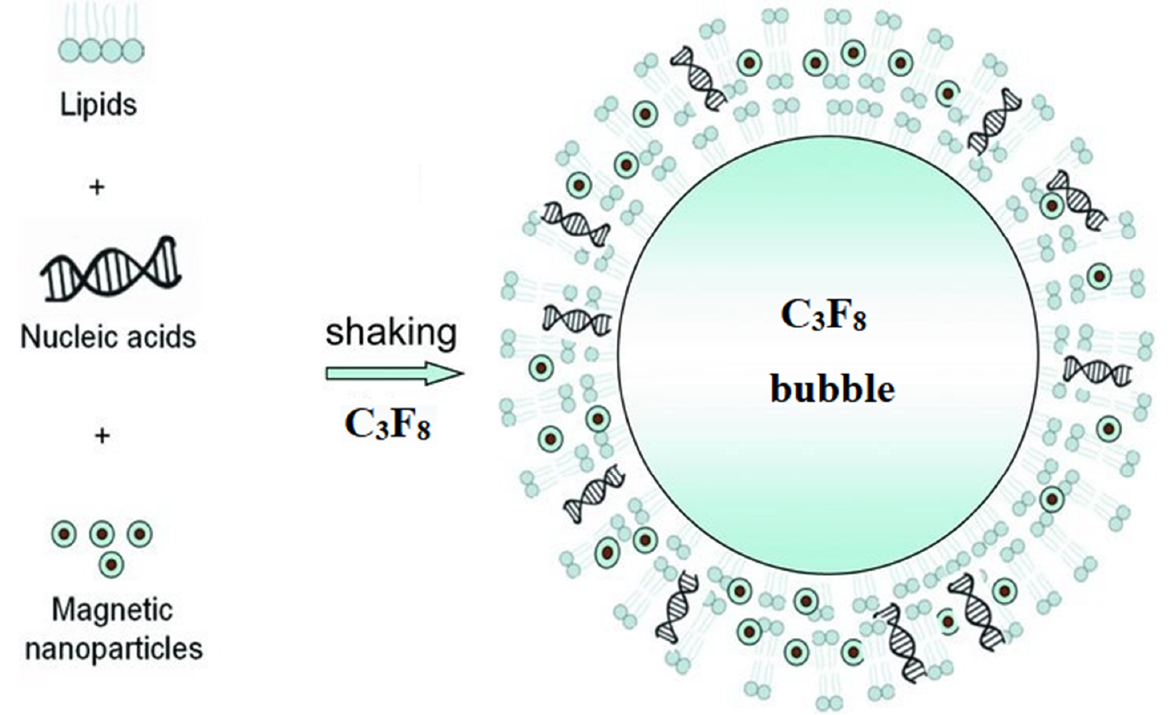
Figure 3. Schematic representation of the self-assembly of the lipids, magnetic nanoparticles, and nucleic acids into magnetic, acoustically active lipospheres upon shaking of the components in an aqueous medium in the presence of perfluoropropane. Adapted with permission from [133]. Copyright John Wiley and Sons,